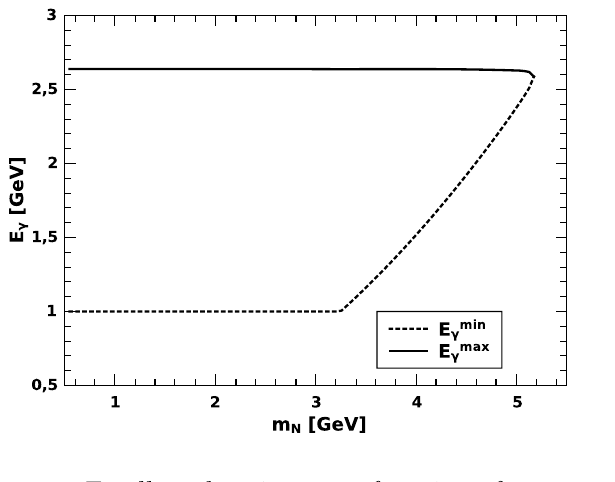
(cid:2)γ Fig. 3 A asymmetry for the SM process B − → μ − ¯ ν μ γ , for each photon energy bin E i FB